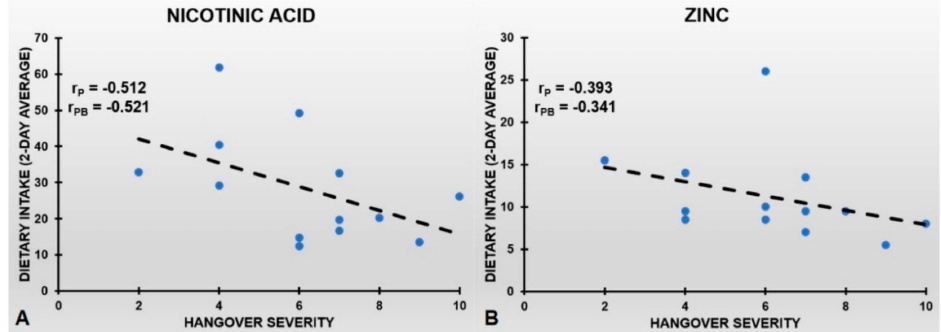
Figure 3. The negative association of dietary nicotinic acid intake (two-day average) and dietary zinc intake with overall hangover severity. Figure 3 shows the partial correlation (r P ), controlled for eBAC, between ( A ) dietary nicotinic acid and ( B ) zinc intake (two-day average) and overall hangover severity.